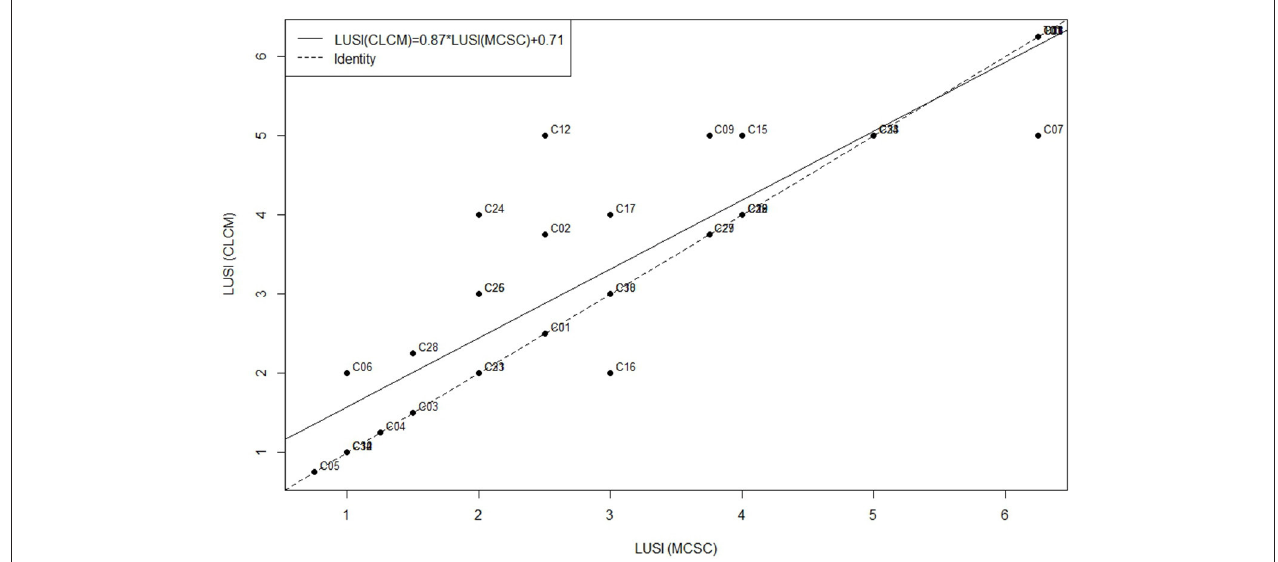
FIGURE 2 | Regression line of the LUSI values calculated for the Catalan coast using the 2006 Coordination of Information of the Environment land cover map (CLCM) and the 2009 Mapa de Cobertes del Sòl de Catalunya (MCSC), drawn as a solid line. The dashed line corresponds to the identity regression. Codes of the water bodies are